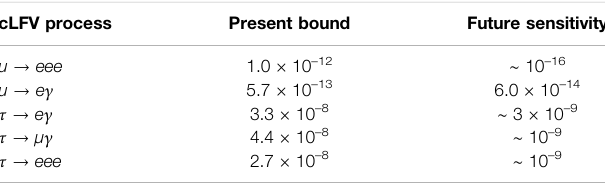
TABLE 1 | Current experimental bounds and future sensitivities of different cLFV processes [10 – 13]. cLFV process Present bound